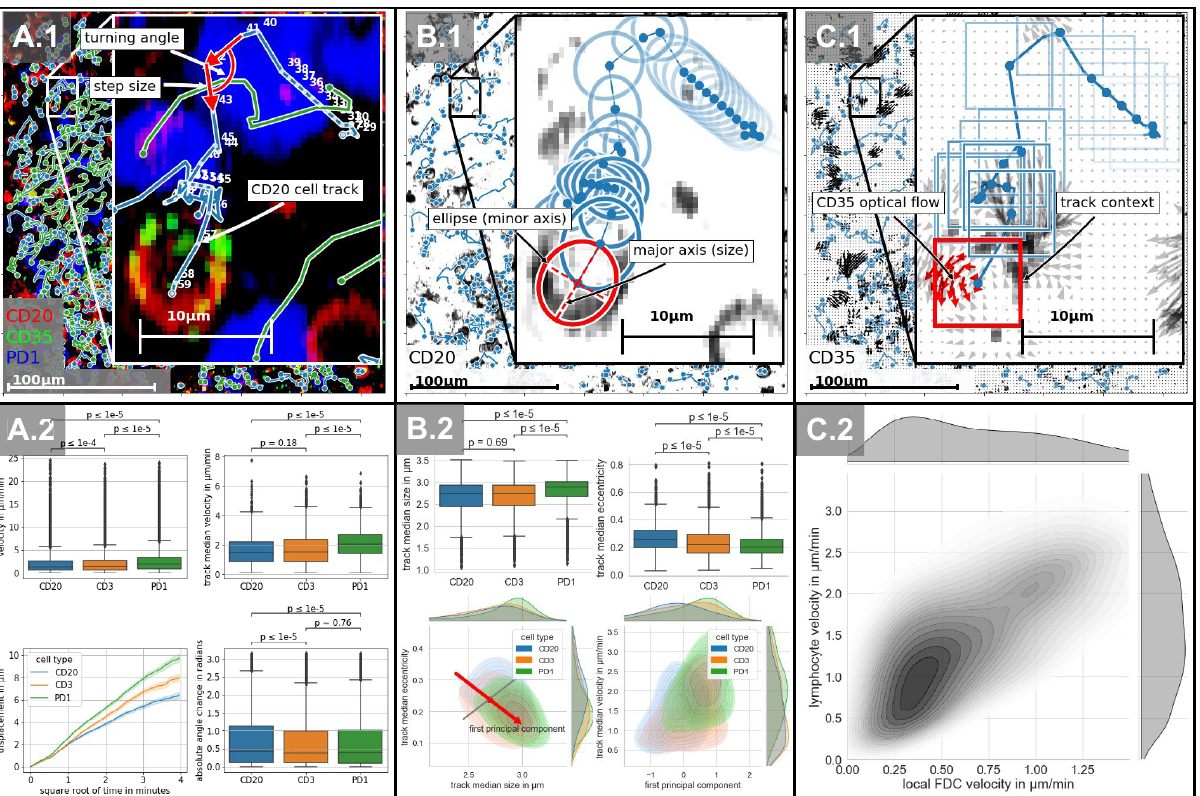
Figure 2. Movement and morphology of lymphocytes in human lymphoid tissue. Column A describes the analysis of the lymphocyte motility based on cell tracks. ( A.1 ) visualizes the definition of the inspected features, turning angle and step size per time frame, later called velocity. ( A.2 ) shows the results of the analysis. Column B describes the morphological analysis of lymphocytes based on cell tracks. ( B.1 ) displays the features used for morphological descriptions, ellipse, to represent the eccentricity and major axis, later defined as cell size. On the upper left of ( B.2 ), the size of each cell type is visualized. Conclusively, column C displays the analysis of CD35 positive follicular dendritic cells (FDC). ( C.1 ) visualizes the major concept of optical flow to determine on spot FDC velocity. ( C.2 ) shows the positive correlation of FDC velocity related to lymphocyte velocity in the